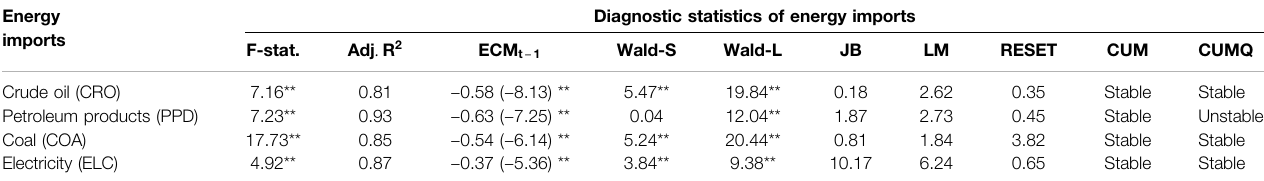
TABLE 4 | Diagnostic statistics associated with the asymmetric